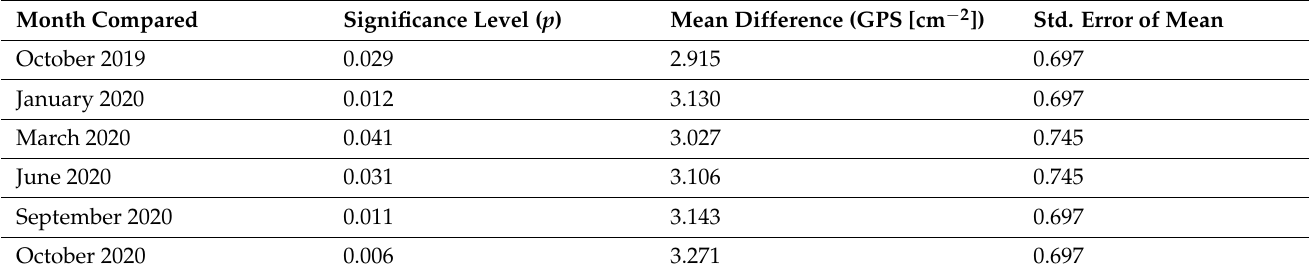
Table A8. Summary of Tukey’s Honestly Significant Differences post-hoc analysis of seasonal density collected across 32-months. Only month pairs that demonstrated significant differences in Marchalina hellenica density (GPS cm − 2 ) are shown ( p < 0.05). Differences were only detected when comparing November 2020, thus all comparisons shown are comparisons with insect density recorded